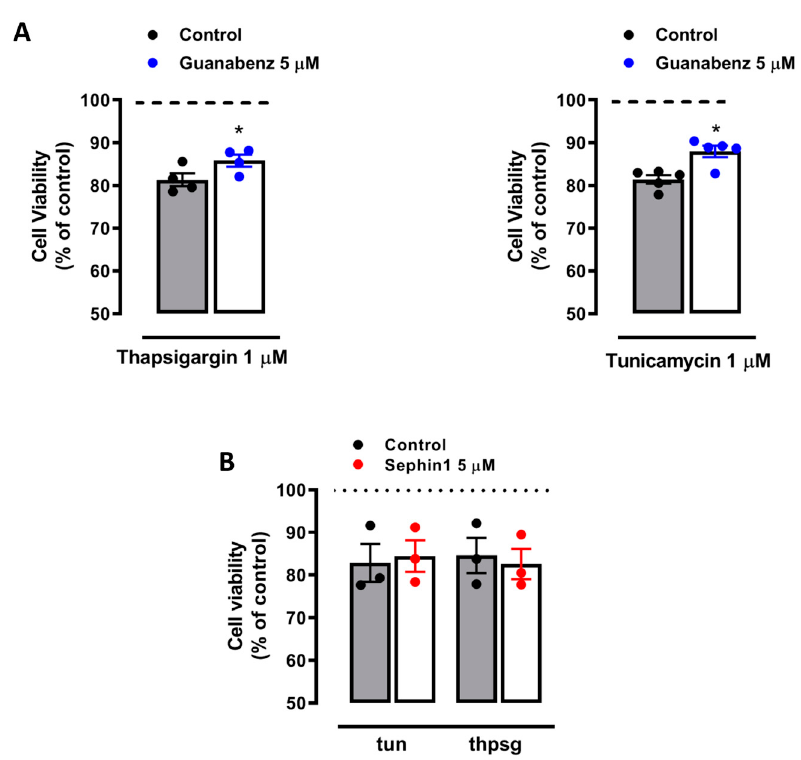
Figure 3. Guanabenz but not Sephin1 reduces ER stress-induced neuronal death. Primary cultured neurons were exposed to tunicamycin and thapsigargin (1 µM both, 24 h) in the absence or presence of ( A ) guanabenz (5 µM, 24 h) and ( B ) Sephin1 (5 µM, 24 h). The number of viable cells was assessed by fluorescent vital dye calcein-AM 24 h later. Histograms represent means ± SEM of calcein fluorescence values normalized to controls. * p < 0.05 compared with cells treated with tunicamycin or thapsigargin alone, paired Student’s t-test.